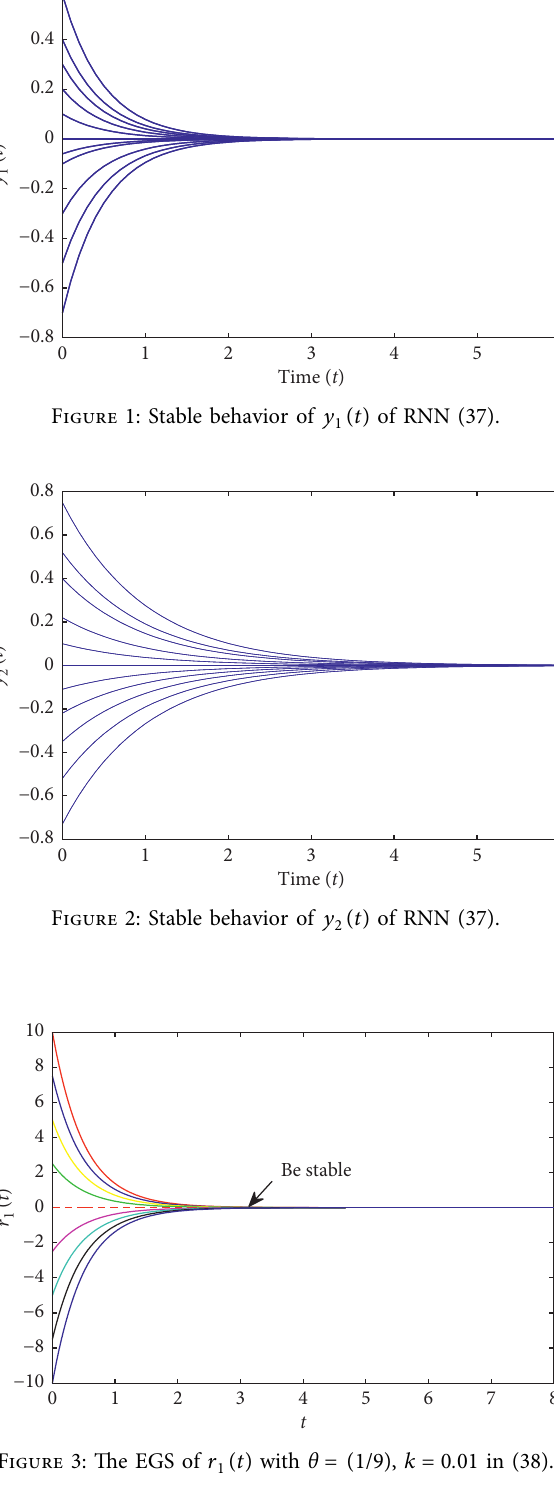
( t ) with θ � ( 1/9 ) , k � 0 . 01 in (38). 1